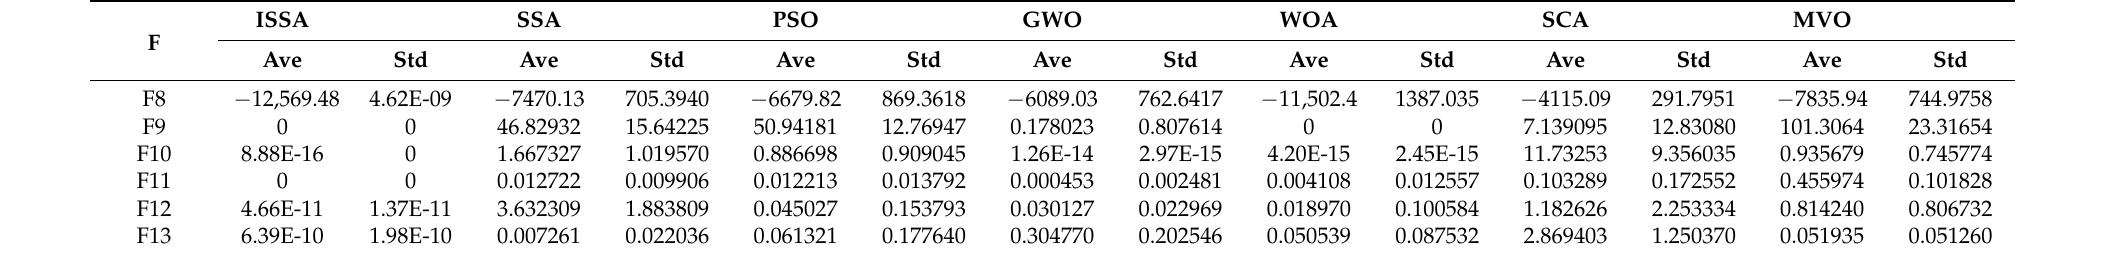
Table 5. Statistical results of ISSA on multimodal benchmark